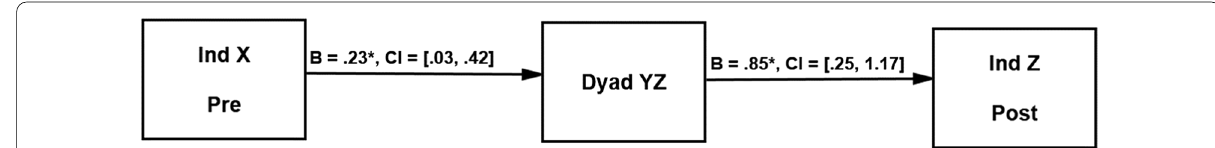
Fig. 2 The reduced path model that measured the indirect social influence of network member X on network member Z through their shared link with member Y. Member X’s pre-collaborative discount rates (Ind X Pre) significantly predicted Dyad YZ’s discount rates even though member X was not directly involved in that collaboration. The significance of the path coefficients (*) was based on whether the 95% bias-corrected bootstrap confidience intervals included zero or